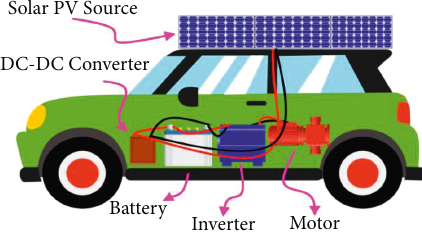
Figure 6: Solar electric vehicle